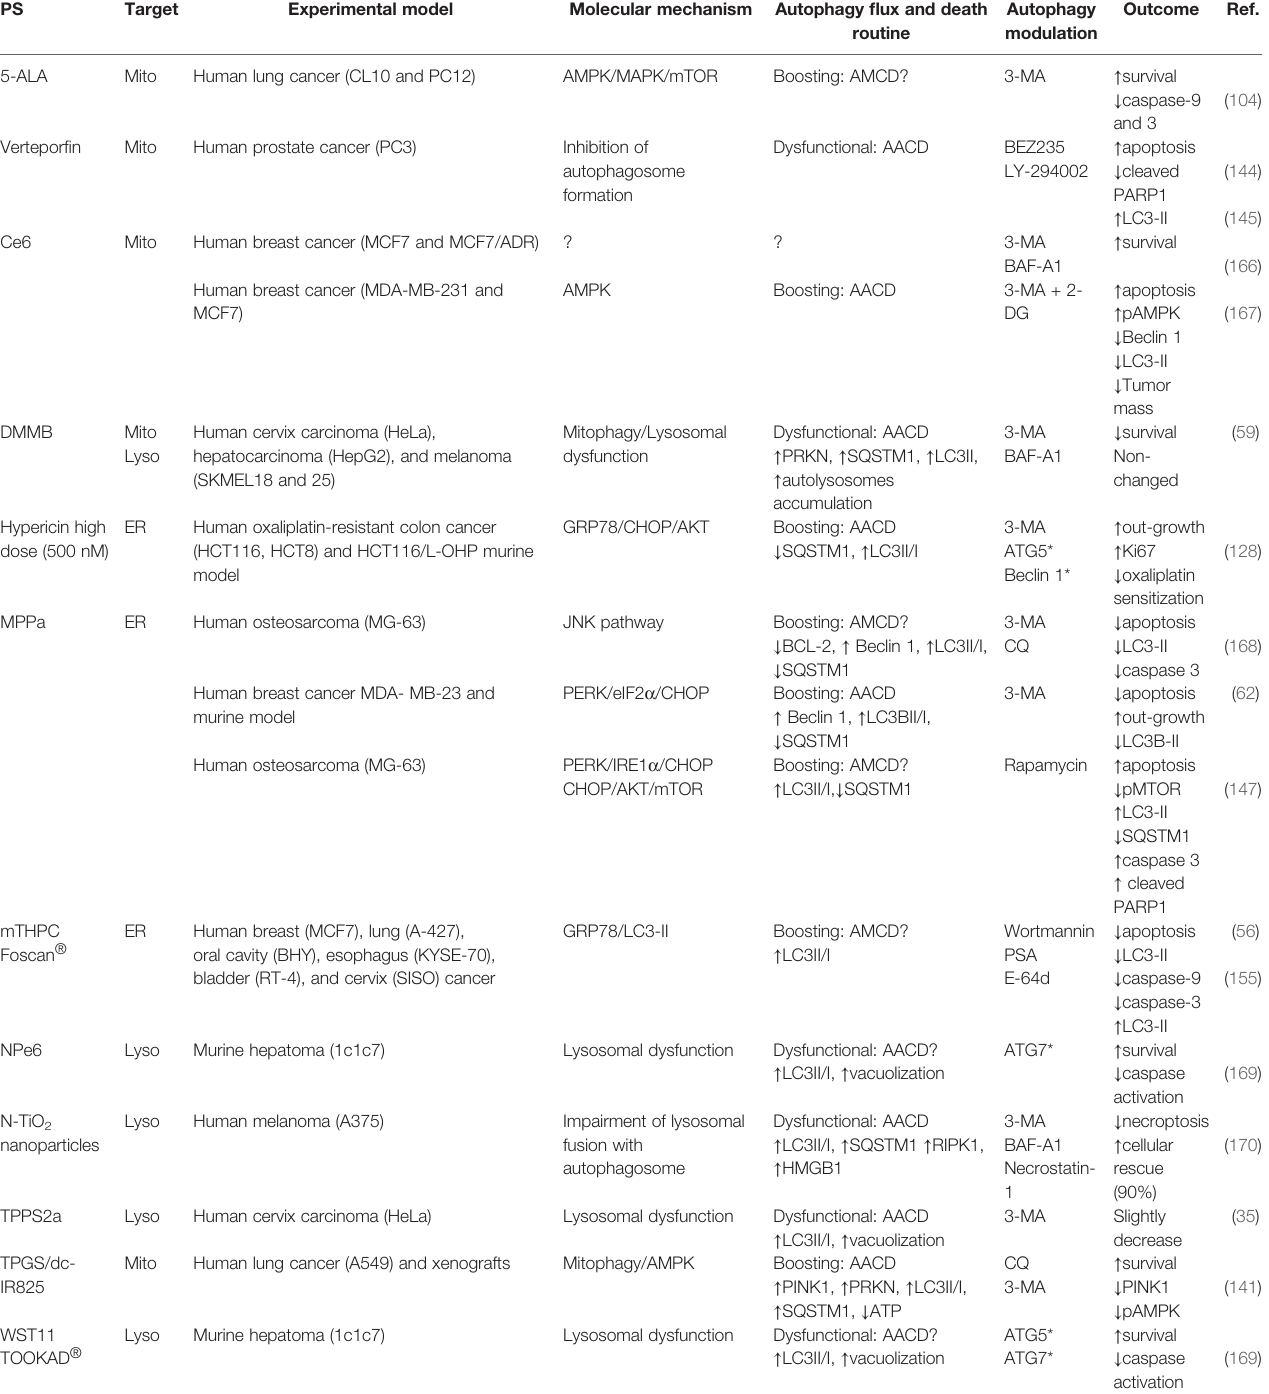
TABLE 2 | PDT-mediated autophagy: death routine and modulatory